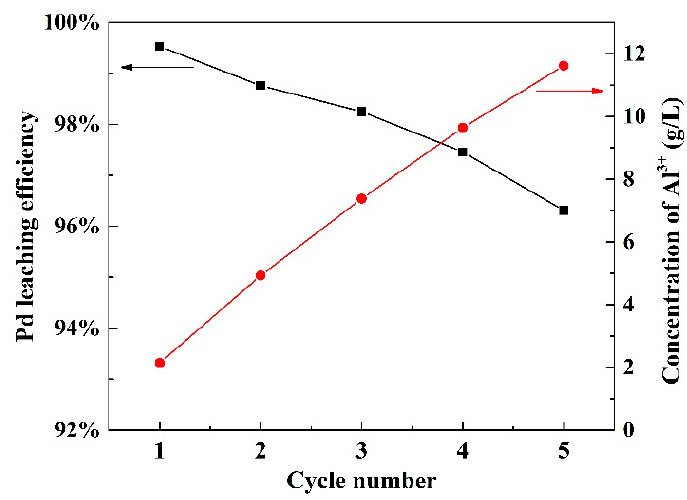
Figure 9. The e ff ect of cycle number of leaching agent on Pd leaching and Al 2 O 3 Figure 9. The effect of cycle number of leaching agent on Pd leaching and Al 2 O 3 dissolution.